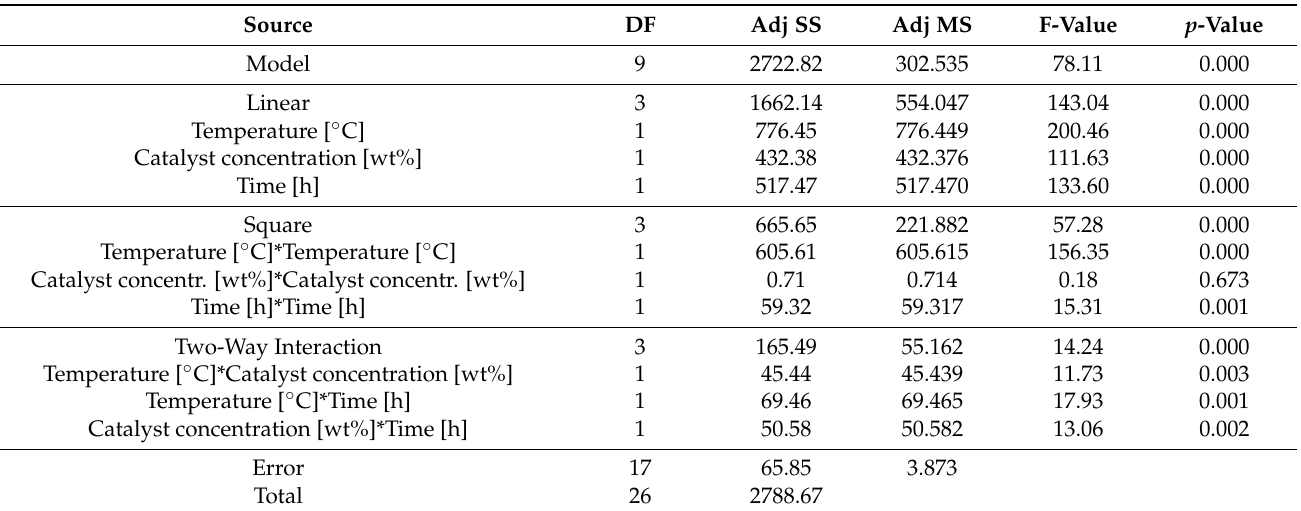
Table 2. ANOVA results for geraniol